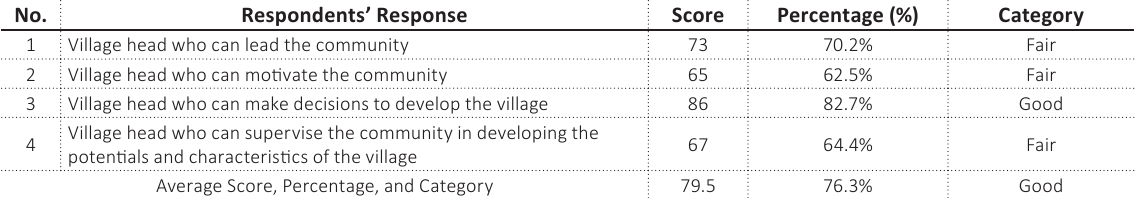
Table 3. Leadership management indicators in the villages of Bilato District